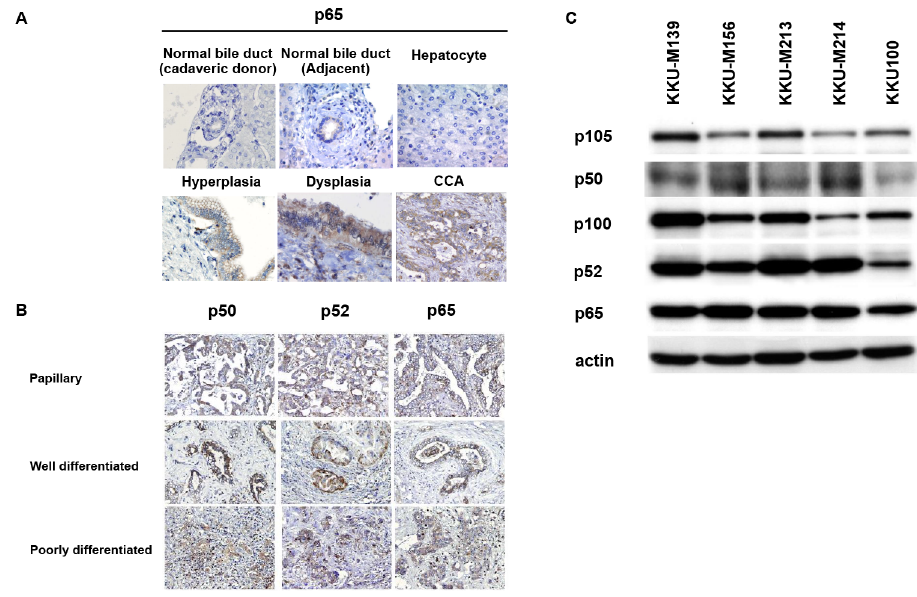
Figure 1. Expression of NF- k B in CCA patients and cell lines. The expressions of NF- k B in CCA tissues were determined by immunohistochemistry. A) Hepatocytes, as well as bile duct epithelia of normal liver tissues from cadaveric donor and of non-tumorous liver tissue from CCA patients showed weak immunoreactivity of NF- k B (p65). The expression of NF- k B, however, was gradually increased in hyperplasia, dysplasia and CCA. B) All NF- k B subunits, p50, p52 and p65, were overexpressed in different histological types of CCA tissues. Original magnification 20X, except normal bile duct, hepatocyte and dysplasia, 40X. C) Expression levels of NF- k B subunits, p50, p52 and p65, were determined in five CCA cell lines by western blotting. The precursors and active forms of NF- k B subunits, p105/p50, p100/p52 and p65, were strongly expressed in all CCA